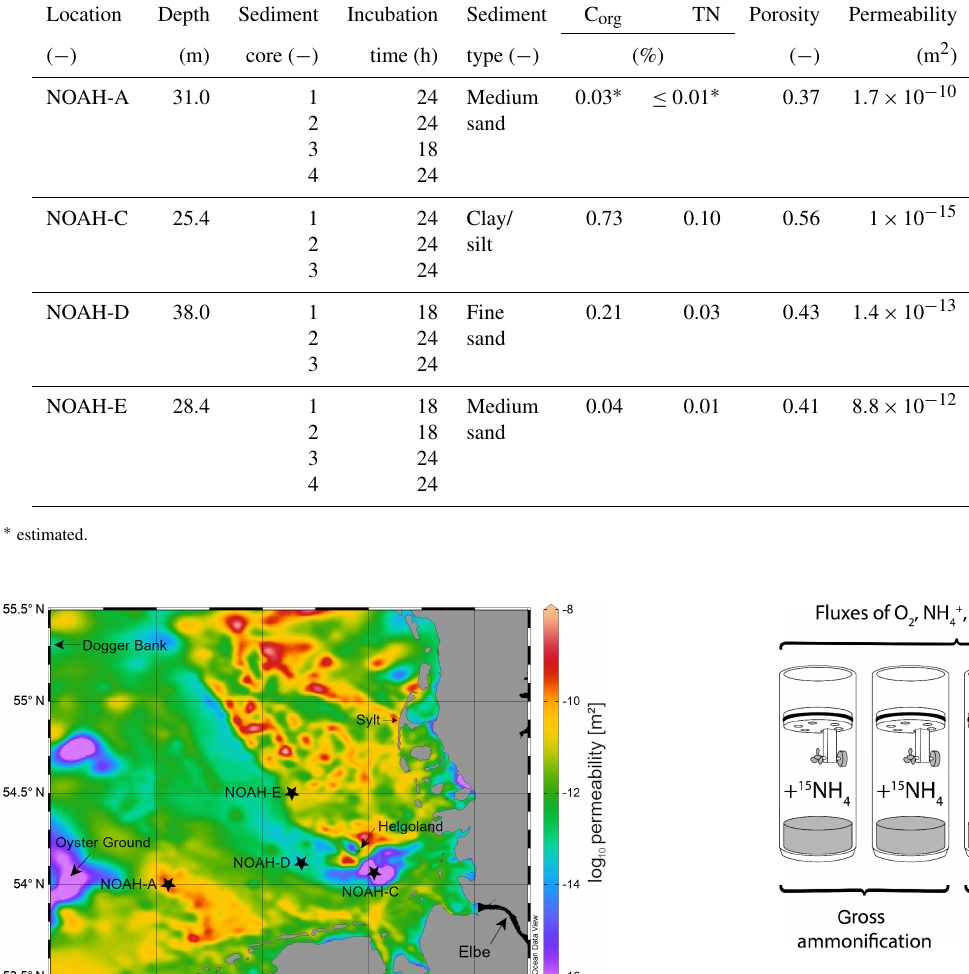
Figure 2. Schematic illustration of the experimental setup. Four sediment cores were incubated to measure benthic fluxes of oxygen, ammonium, nitrate and N 2 . Two of these flux cores were amended with either 15 NH + or 15 NO − for the measurement of gross rates of 4 3 ammonification and nitrification,